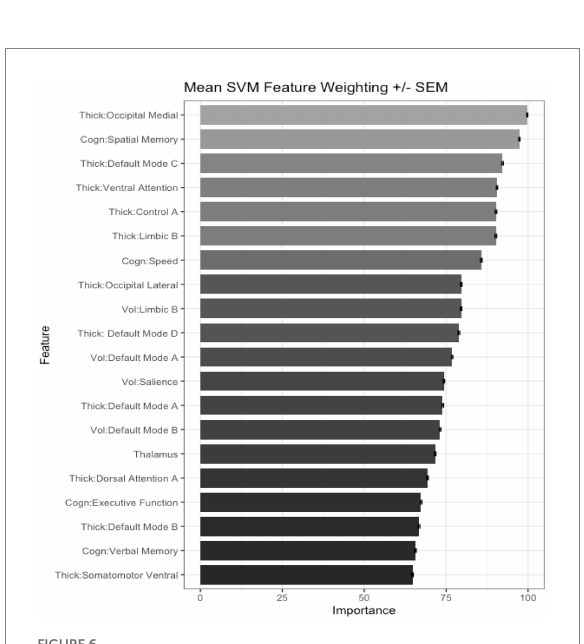
FIGURE 6 Bar plots showing the top 20 important features in the BrainAGE algorithm.